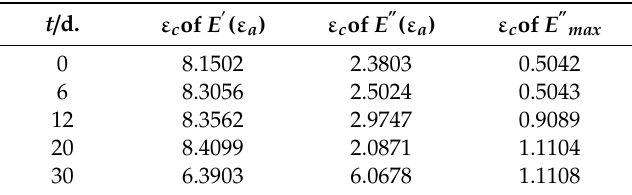
Table 3. Model fitting and test results of ε c